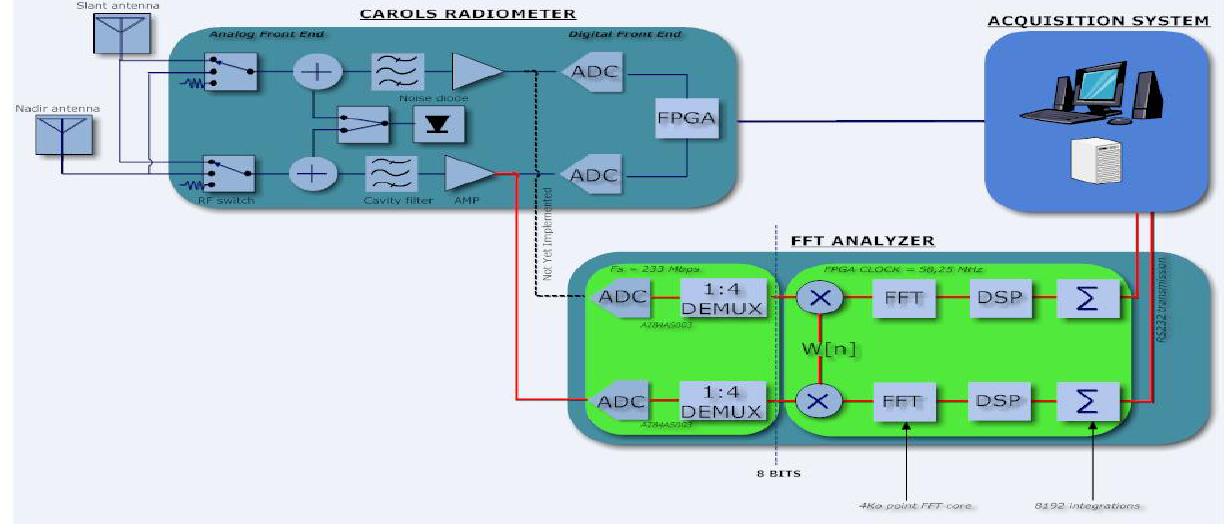
Figure 1. Block diagram of the CAROLS radiometer and (FFT) spectrum analyzer. The red connection was not fully operational during the 2009 CAROLS